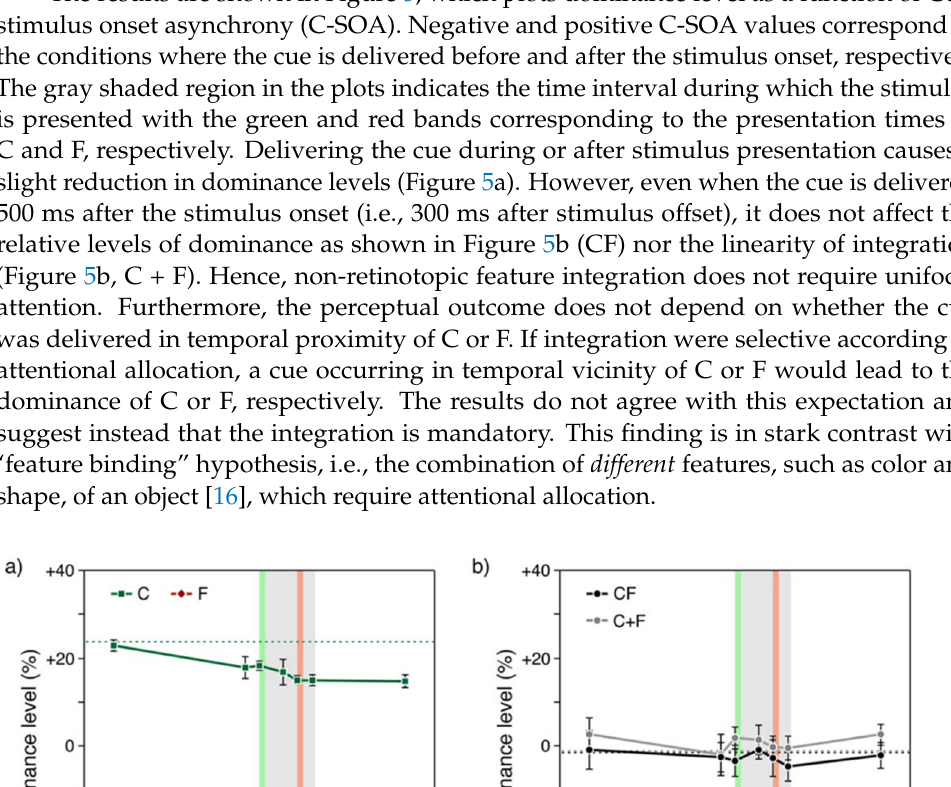
cisions are not based on a single Vernier offset, arbitrarily chosen by the observer, but on a mandatorily integrated offset. a mandatorily integrated